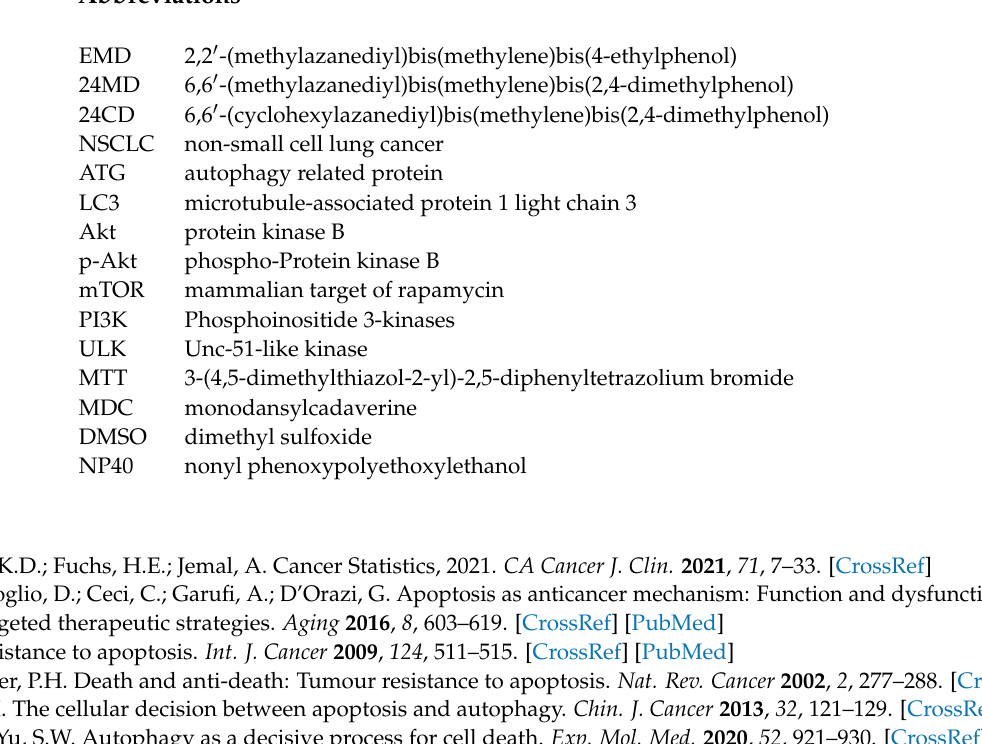
spectrum of EMD, Figure S2: 1 H-NMR spectrum of EMD, Figure S3: 13 C-NMR spectrum of EMD, Figure S4: Fourier-transform infrared spectrum of 24MD, Figure S5: 1 H-NMR spectrum of 24MD, Figure S6: 13 C-NMR spectrum of 24MD, Figure S7: Fourier-transform infrared spectrum of ECD, Figure S8: 1 H-NMR spectrum of ECD, Figure S9: 13 C-NMR spectrum of